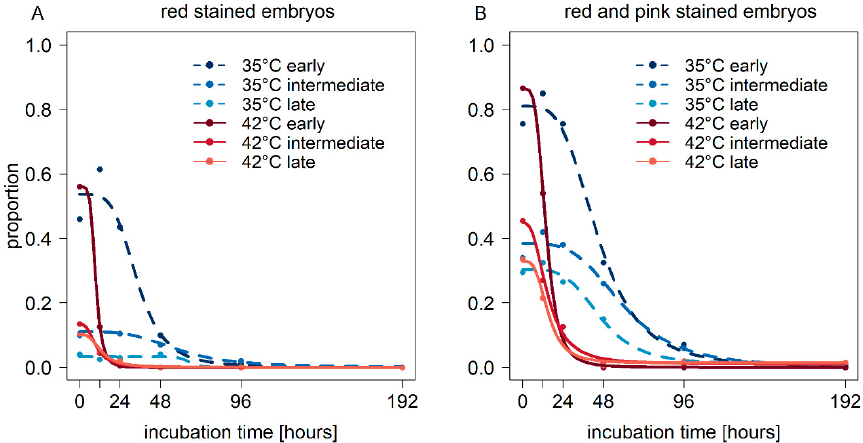
Figure 2. Survival probability of Heracleum mantegazzianum seeds as a function of proportion of stained seeds depending on incubation time to water bath at 35 and 42 °C, for harvest times: 2 weeks (early), 5 weeks (intermediate), and 8 weeks (late) after flowering. Survival probability for: ( A ) Red stained embryos, ( B ) Pink and red stained embryos.